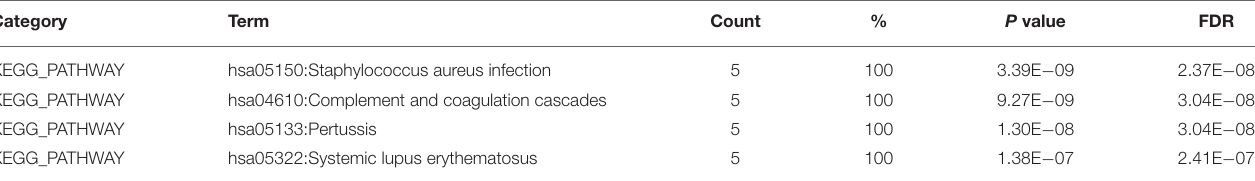
TABLE 2 | Enrichment analysis of KEGG pathway of module 1. Category